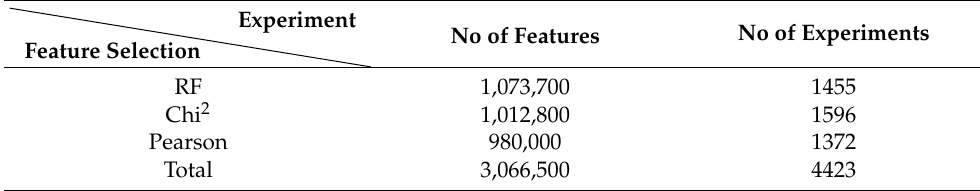
Table 5. Analysis for the number of features and experiments.